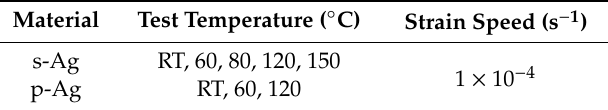
Table 1. Tensile test conditions.